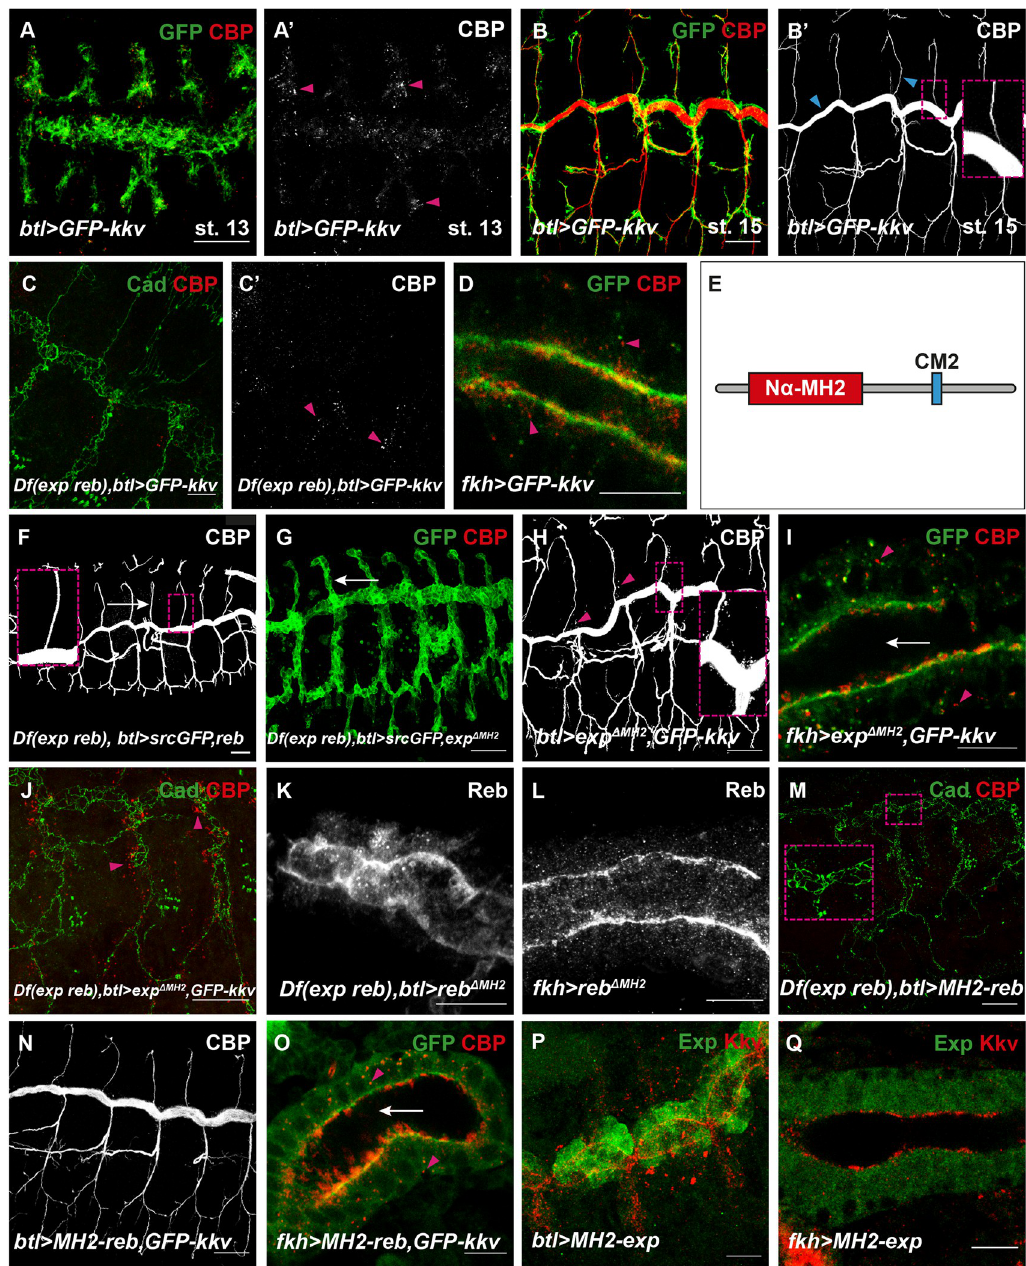
Fig 1. Analysis of the role of the N α -MH2 domain of Exp/Reb. All images show projections of confocal sections, except D, I, L, O, and Q, which show single confocal sections. ( A , B ) The overexpression of GFP-kkv in the trachea leads to the presence of intracellular chitin vesicles at early stages (pink arrowheads) ( A , A’ ). At later stages, intracellular chitin vesicles are not present, and chitin is deposited extracellularly in the lumen (blue arrowheads and inset) ( B , B’ ). ( C , C’ ) In exp reb mutants, the overexpression of GFP-kkv in the trachea produces intracellular chitin punctae until late stages (pink arrowheads). ( D ) The overexpression of GFP-kkv in salivary glands produces intracellular chitin vesicles (pink arrowheads). ( E ) Schematic representation of Exp protein. ( F , G ) In exp reb mutants, the expression of a wild-type form of exp/reb rescues the lack of extracellular chitin deposition ( F , white arrow and inset), while exp Δ MH2 /reb Δ MH2 do not ( G , white arrow points to absence of CBP). ( H , I ) The co-overexpression of GFP-kkv and exp Δ MH2 in control embryo does not produce morphogenetic defects in trachea ( H ) or extracellular chitin deposition in salivary glands (white arrow) ( I ); however, intracellular chitin punctae are present (pink arrowheads in H , I , and inset in H ). ( J ) The coexpression of GFP-kkv and exp Δ MH2 in exp reb mutants produces intracellular chitin particles (pink arrowheads) but does not rescue the lack of extracellular chitin deposition. ( K , L ) Reb Δ MH2 localises apically in trachea ( K ) and in salivary glands ( L ). ( M ) MH2-reb is not able to rescue the absence of extracellular